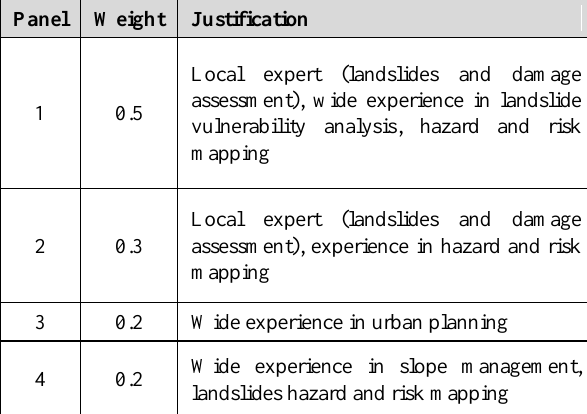
The landslide types (based on materials and process) as